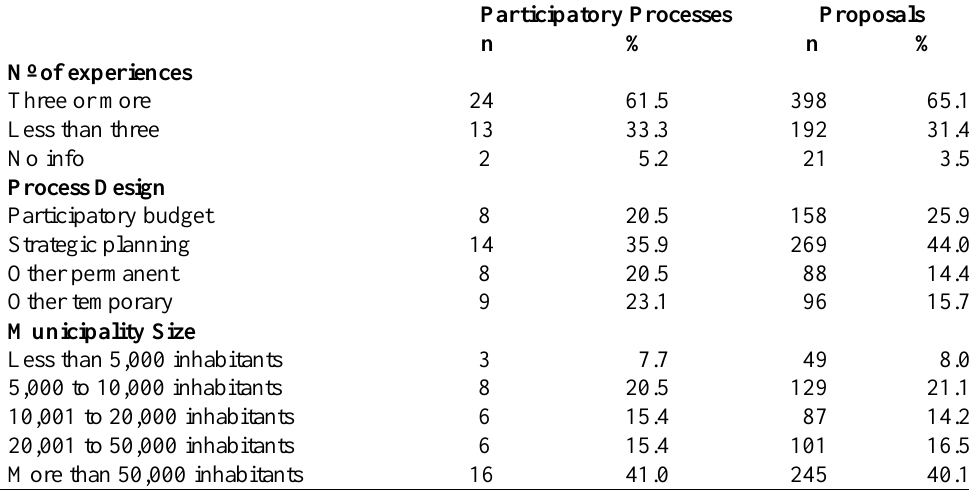
Accomplished sample composition